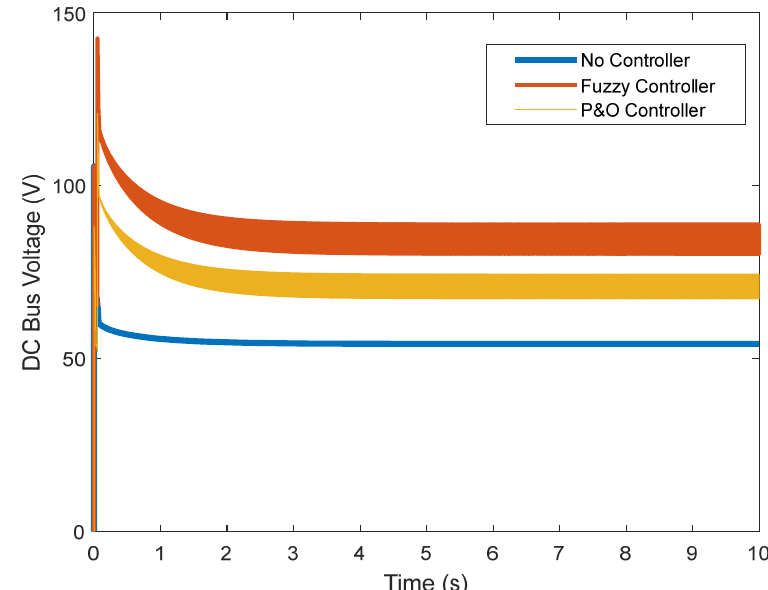
Figure 13. DC link voltage. Figure 13. DC link